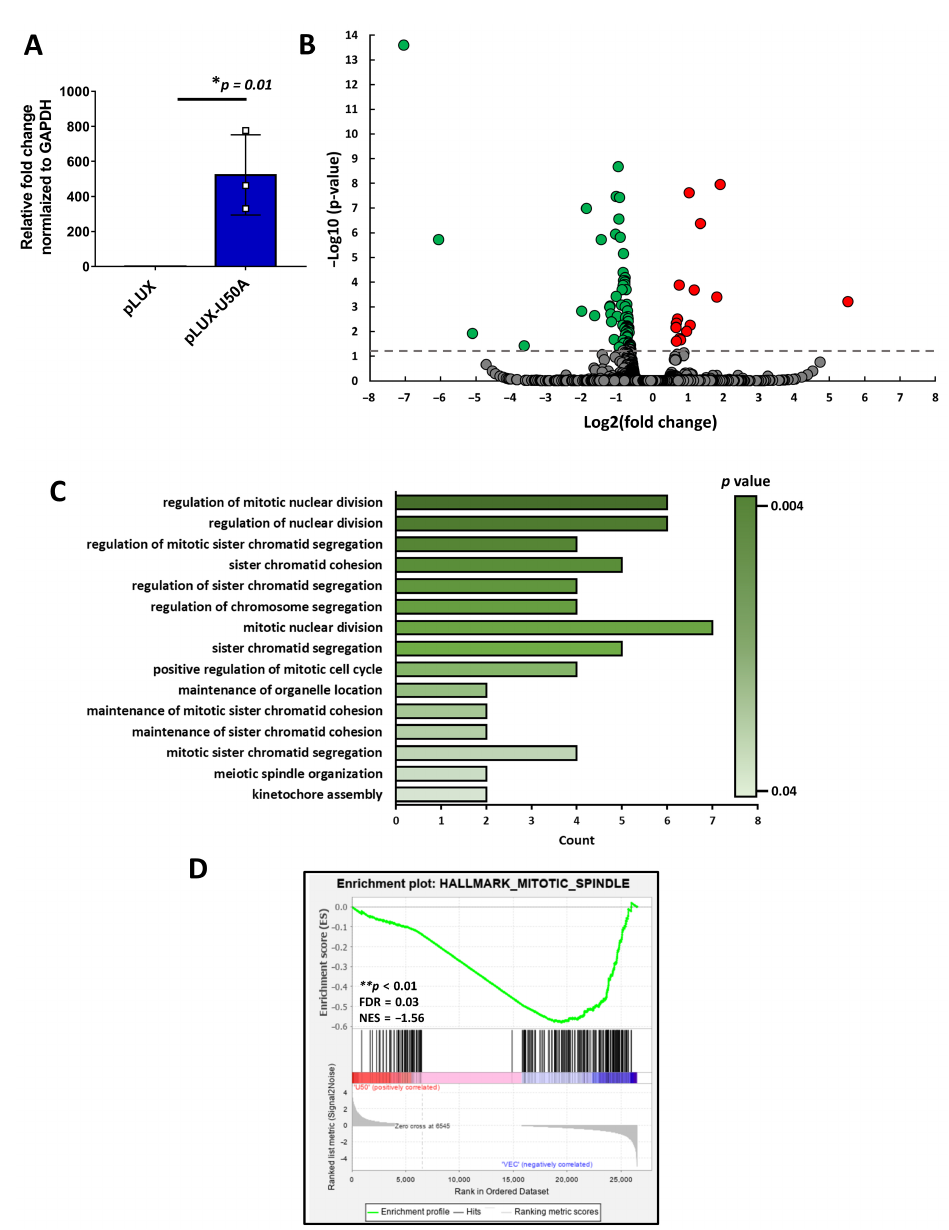
Figure 2. Transcriptomic changes regulated by U50A. ( A ) Fold change of U50A in samples used for RNA sequencing. * p < 0.05. ( B ) Volcano plot of RNA-sequencing results. Green and red dots represent significantly downregulated and upregulated genes, respectively. The gray line indicates the p value of 0.05. ( C ) Bar chart of significantly downregulated Gene Ontology terms in the biological process category. ( D ) Enrichment plot of the GSEA results in the hallmark gene set (NOM p < 0.01; FDR = 0.03; NES = − 1.56) ** p <